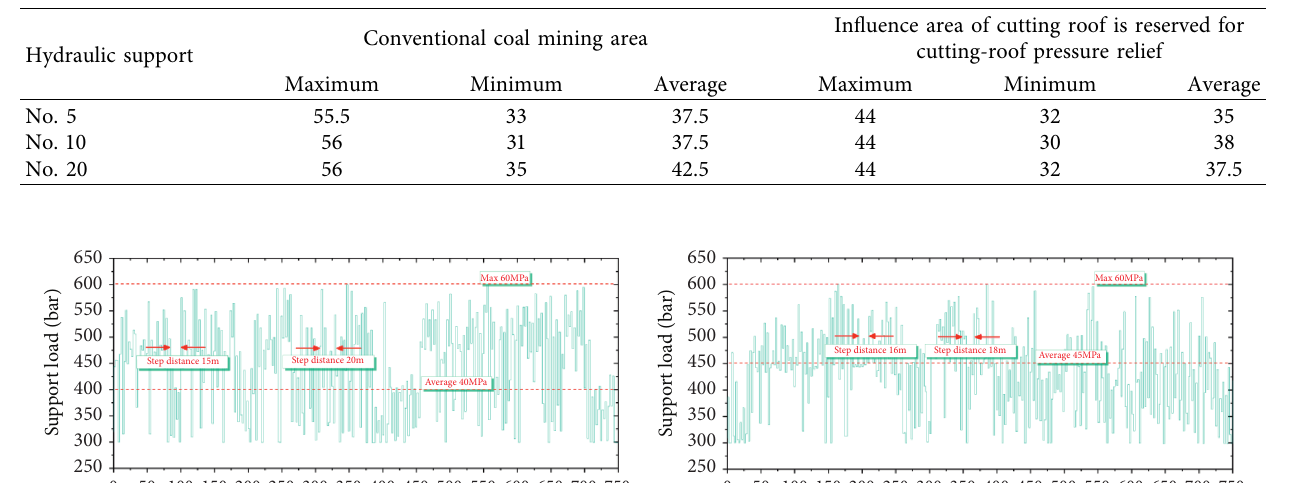
Table 2: Support load (MPa) in areas affected by roof cutting in the roof-unloading and retaining